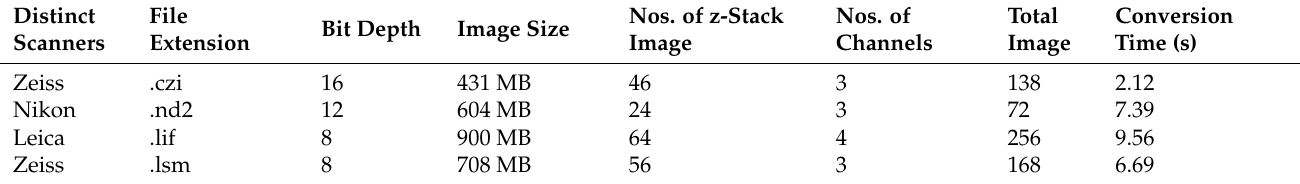
Table 1. CLSM to DICOM conversion framework performance measured by passing four distinct proprietary